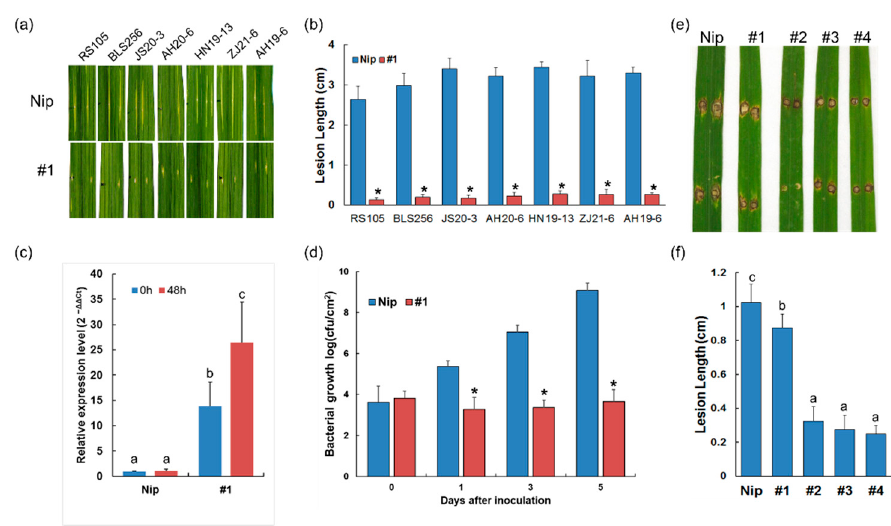
Figure 4. Ectopic expression of Xa23 enhances resistance to multiple rice diseases. ( a ) BLS disease phenotypes of the T 2 plants at tillering stage inoculated with Xoc strains with leaf pin-pricking method at OD600 = 1.0. ( b ) BLS lesion lengths in the T 2 plants. Column height shows mean lesion length (cm), and error bars indicate the standard deviation of three replicates. ( c ) The expression of Xa23 was evaluated by qRT-PCR at 48 h post inoculation with Xoc strain RS105. Data are means ± SD of four biological replicates. ( d ) Bacterial populations in the leaves challenged with Xoc strain RS105. P value were calculated by t-test, * p < 0.05. ( e ) Blast disease phenotypes in the T 2 plants at seeding stage and 7 days after punch inoculation with M . oryzae strain Rb-17 (~5 × 10 5 spore/mL). ( f ) Blast lesion lengths caused by M. oryzae strain Rb-17. For ( c , f ), different letters indicate a statistically significant difference between values ( p < 0.05).